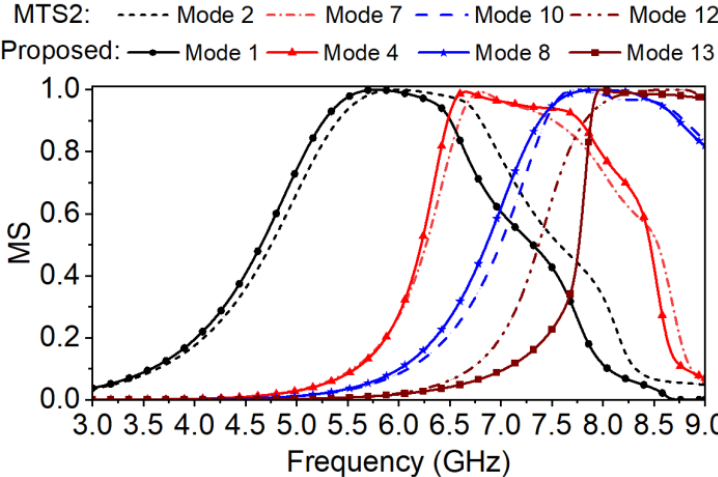
Figure 6. The MSs of the proposed metasurface (MTS3) in comparison with those of MTS2.